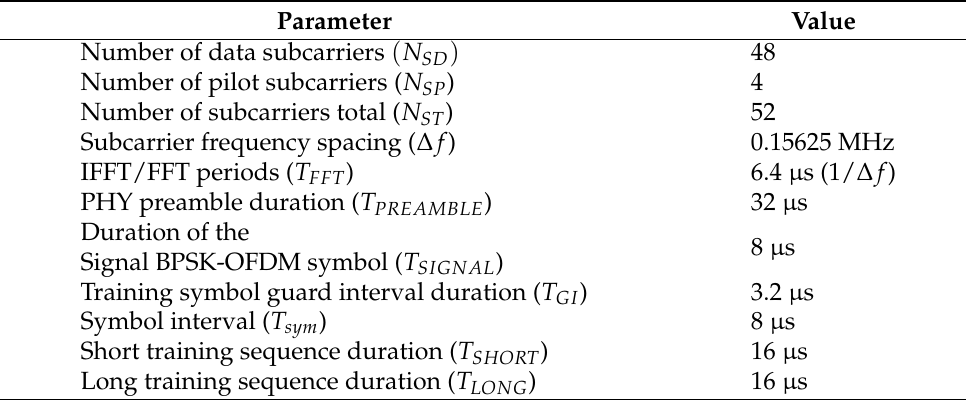
Table 1. IEEE 802.11p system parameters for a 10 MHz channel.